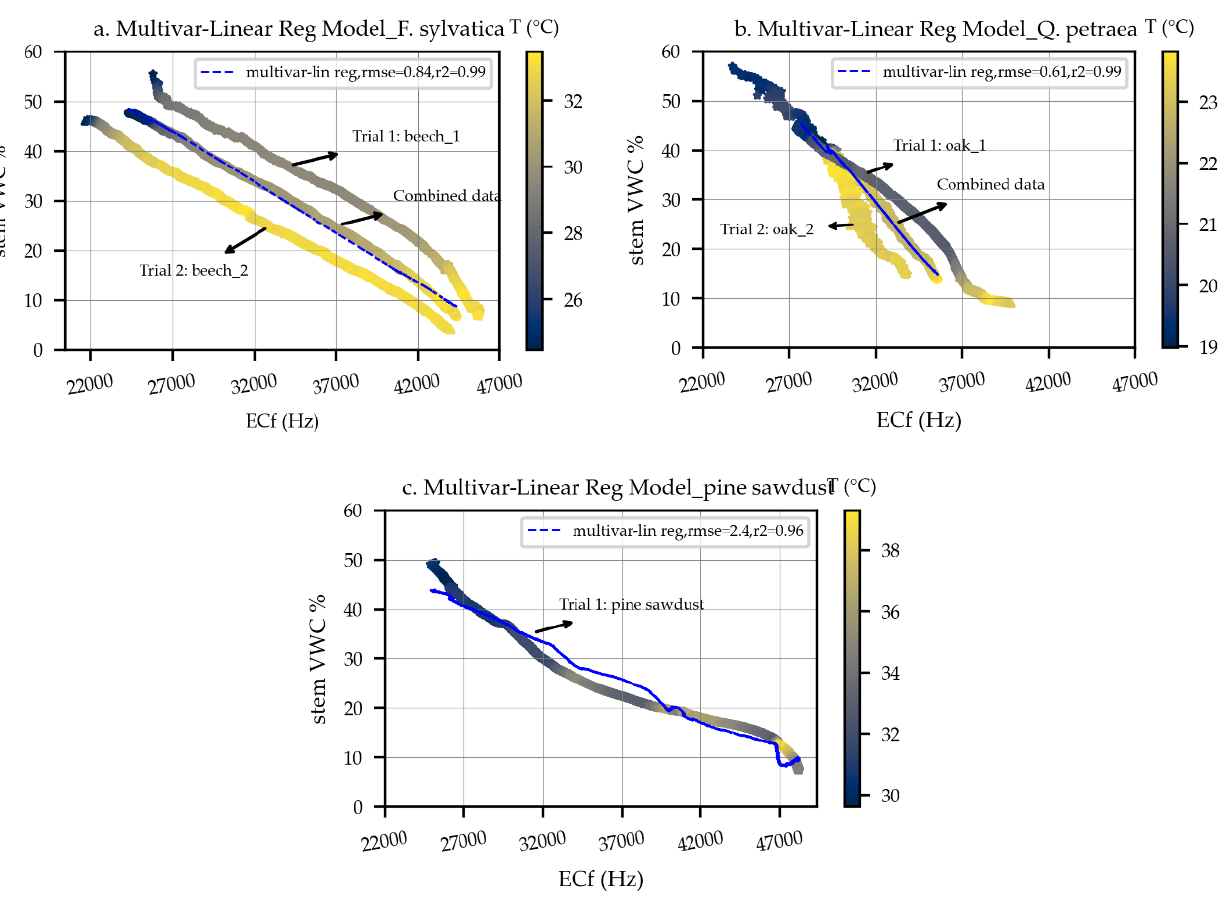
Figure 9. Relationship between Ref probe’s output: ECf and sample temperature versus the digital balance output: stem volumetric water content across the selected samples, ( a ) Beech, ( b ) Oak, and ( c ) pine sawdust.